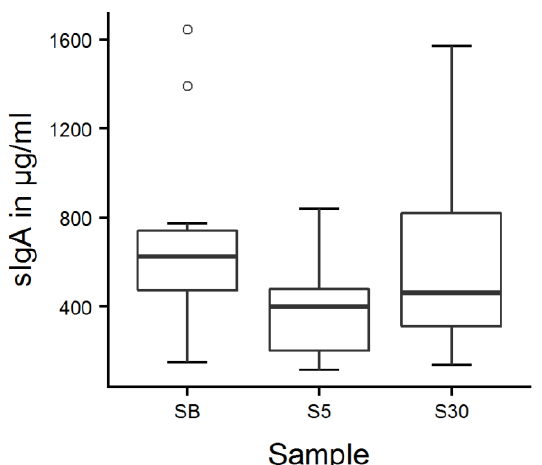
Figure 4. Calves’ salivary sIgA concentrations around feeding time. Fourteen calves were sampled 15 min before (SB), 5 min (S5), as well as 30 min after the milk feeding (S30), which took place twice a day on two consecutive days; values were averaged per calf and point in time. There was a main effect of sample number (LMM, p = 0.007); values decreased from SB to S5 ( p = 0.007) and increased from S5 to S30 ( p = 0.049) according to Tukey contrasts.